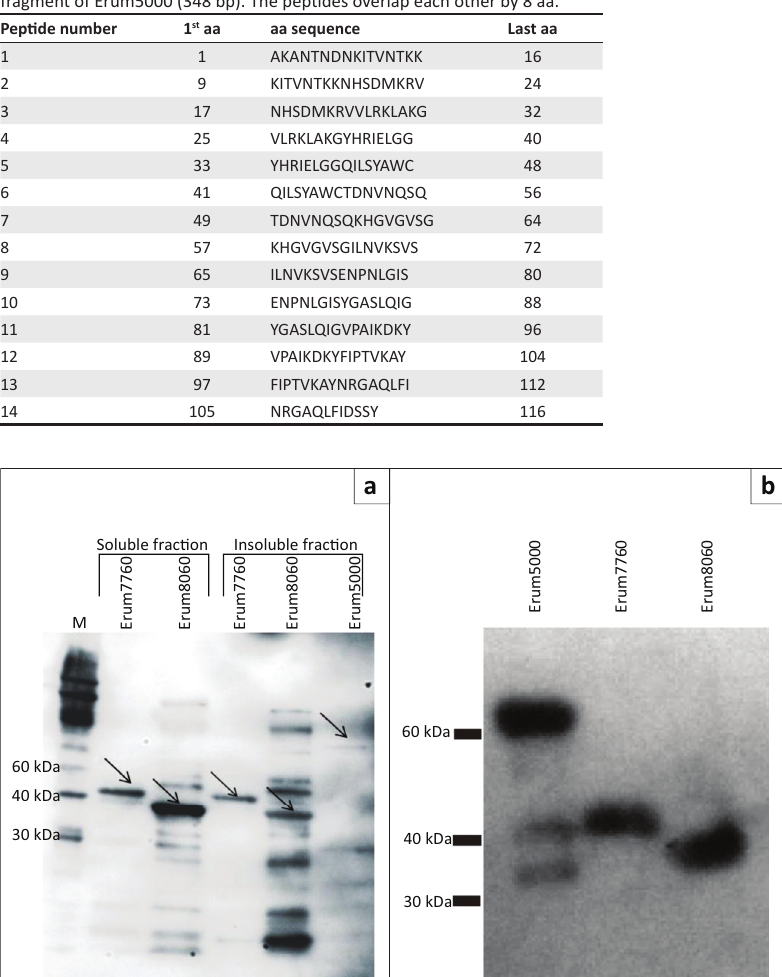
TABLE 2-A1: Fourteen 16 mer synthetic peptides spanning the N-terminal fragment of Erum5000 (348 bp). The peptides overlap each other by 8 aa.